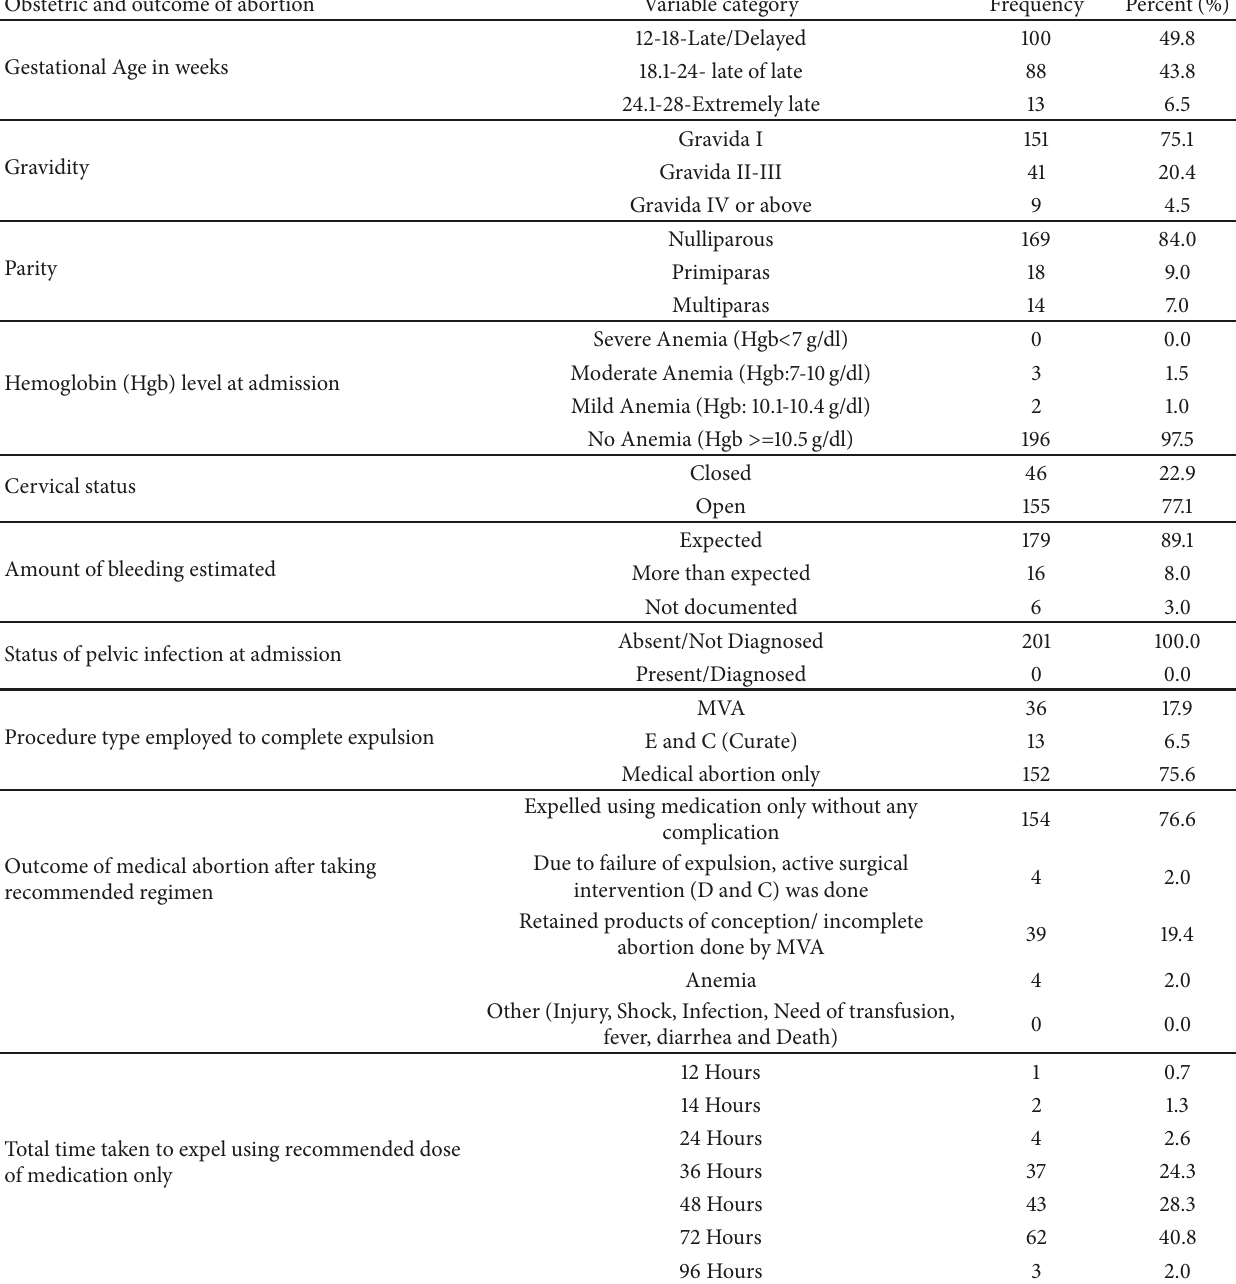
Table 3: Obstetric and outcome of abortion related variables of women terminated pregnancy using safe medical abortion at 2nd trimester in JUMC from November 1, 2016, to June 30,